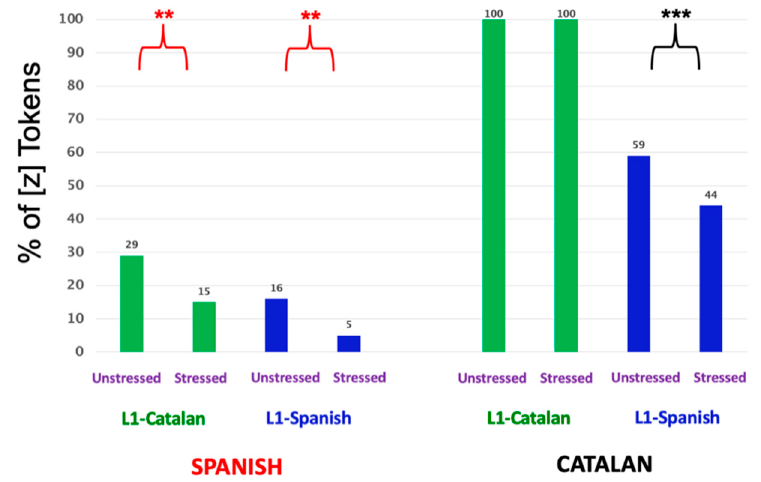
Figure 14. Effect of stress as mediated by language profile and language on Barcelonan fricative production.